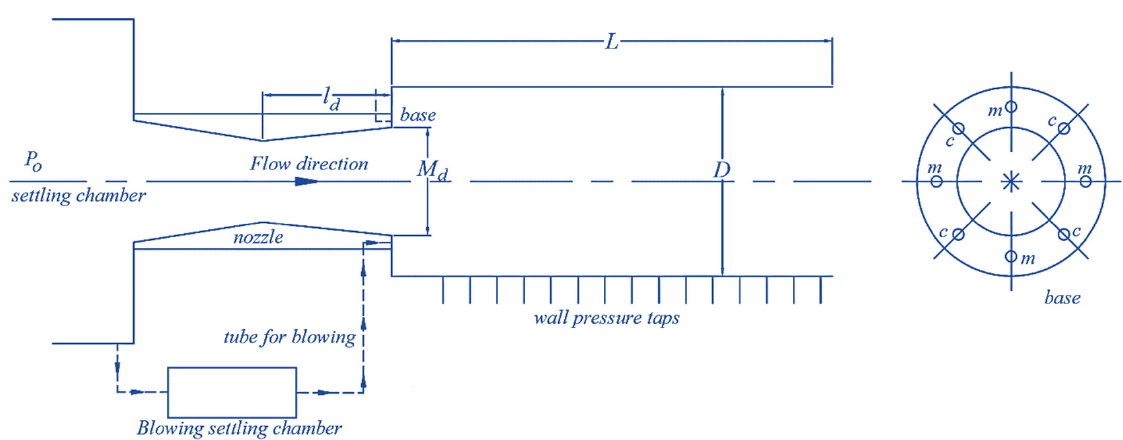
Figure 7. Experimental setup [93]. Reprinted under the Creative Commons (CC) License (CC BY 4.0).